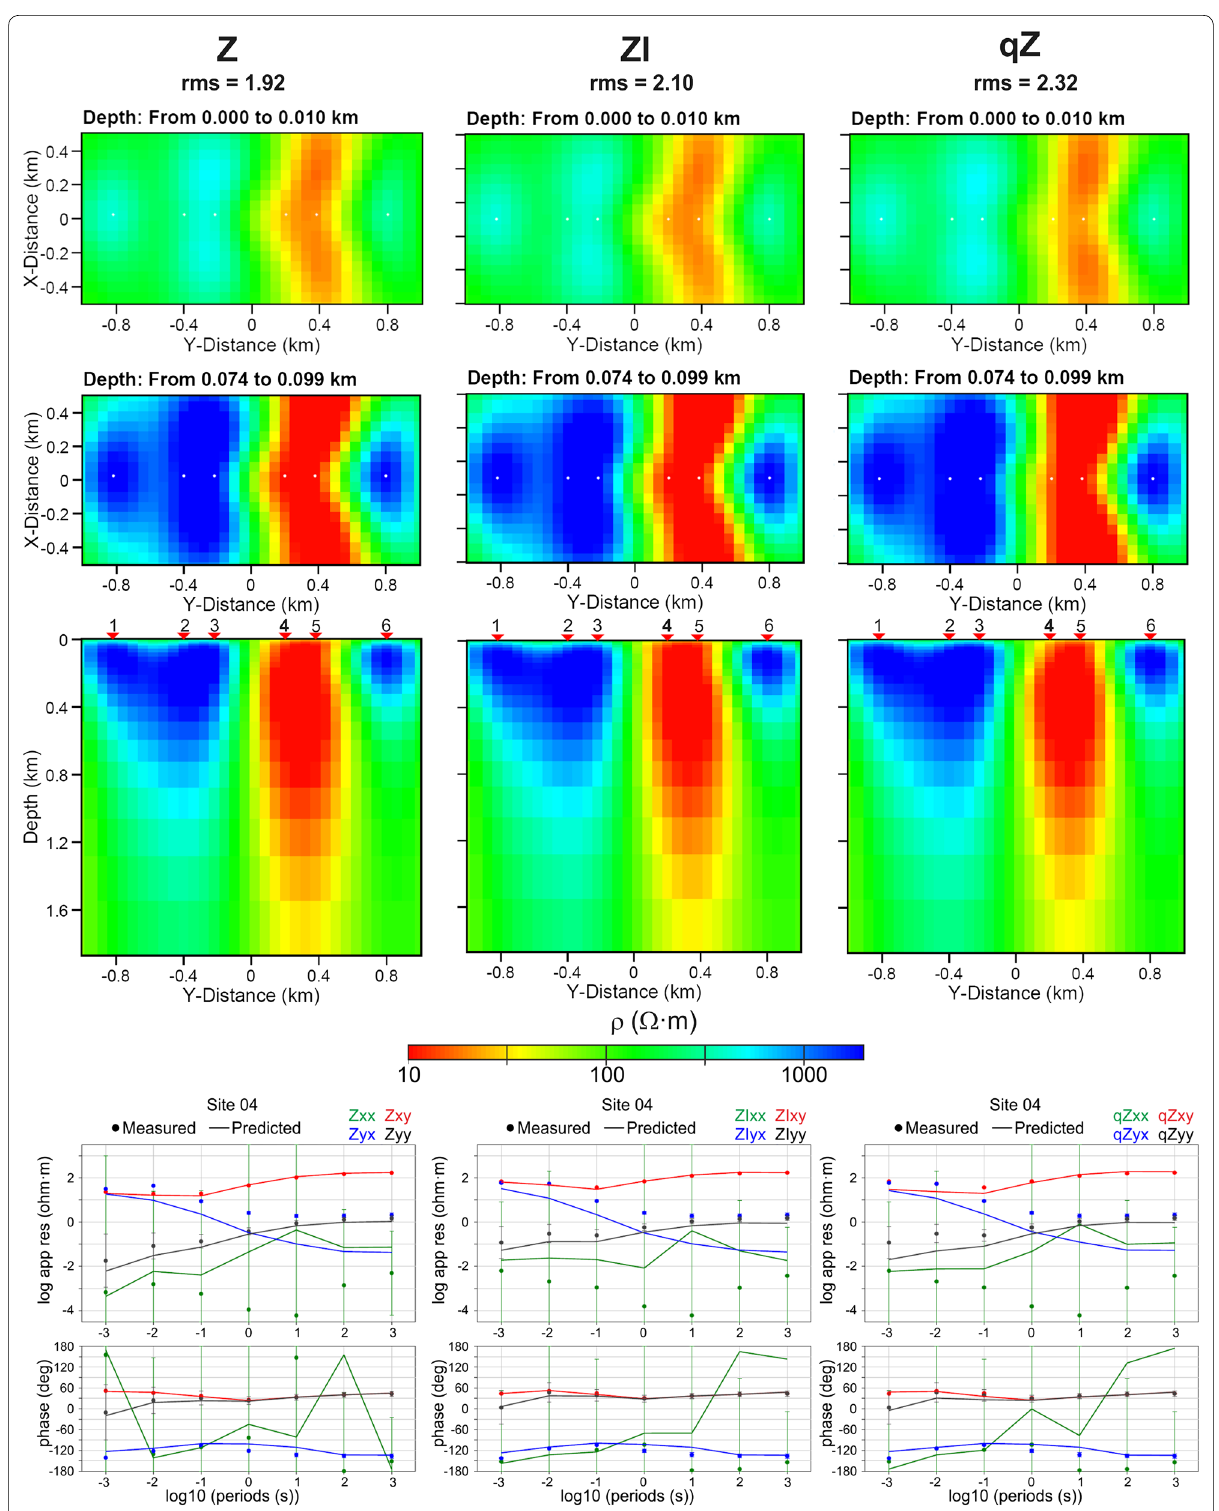
Fig. 5 From top to bottom: plan views at two different depths, cross section beneath the profile and measured and predicted responses at Site 4 corresponding to the models obtained by inverting the synthetic data from Model 2: a impedance Z (left); b1 interstation impedance ZI ( E :4; B :6) (middle) and, b2 quasi‑impedance qZ ( E :4; B :6)